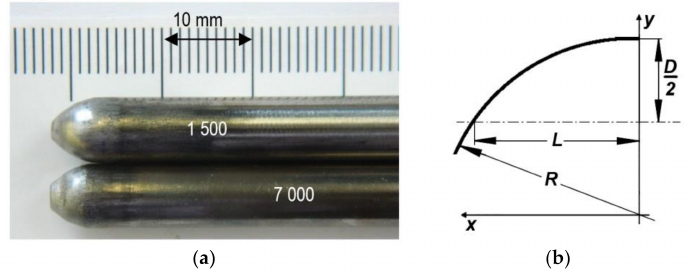
Figure 2. Punches after wearing: ( a ) Punches after hole-flanging; ( b ) the tip geometry.